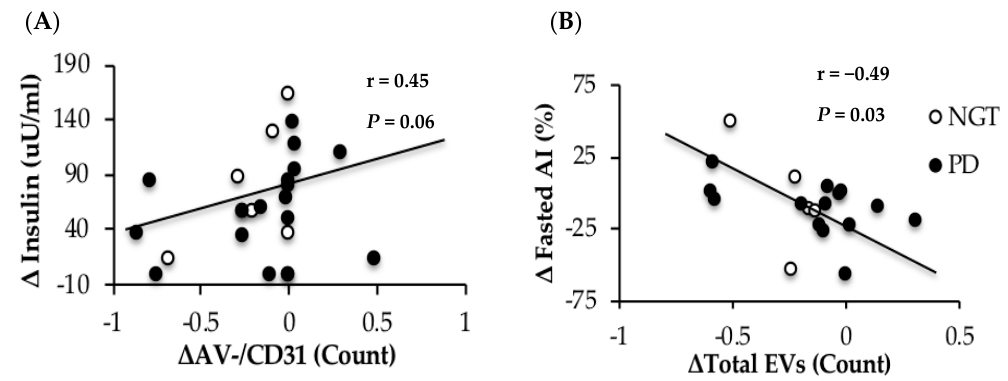
Figure 3. Correlation between changes ( ∆ ; fed-fasted) in EVs, insulin ( A ) and arterial stiffness, as assessed by augmentation index ( B ) EV data were